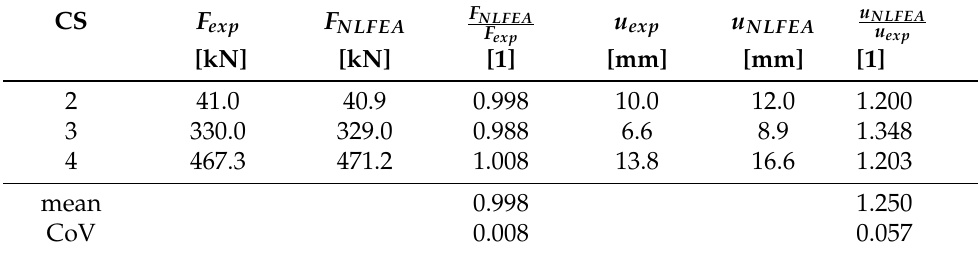
Table 2. Summary of presented case studies; accuracy of ultimate force prediction ( F ) and deflection corresponding to it ( u